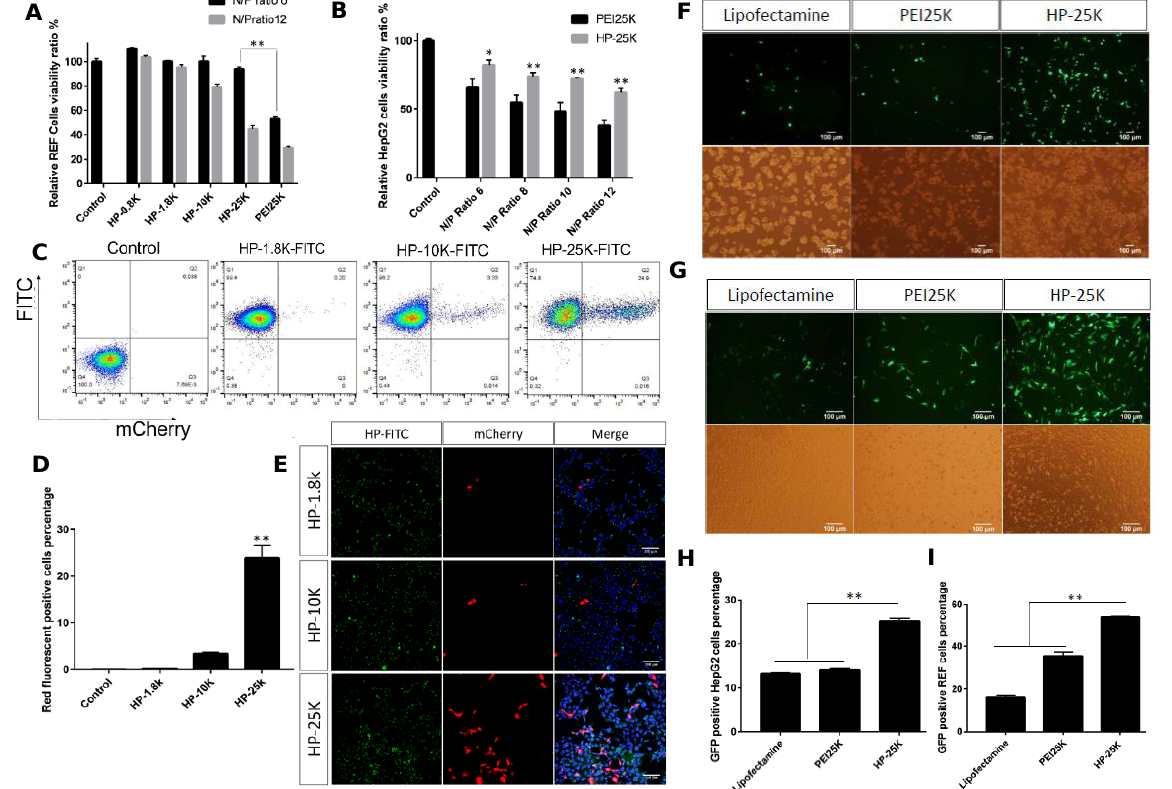
Figure 3. HPs safely and efficiently deliver fluorescence reporter gene pDNAs to various cell types. ( A ) REF cell survivability after transfection with different size HP-pDNA polyplexes. ( B ) HepG2 cell survivability after transfection with HP-25K or PEI25K -pDNA polyplexes at different N/P ratios. ( C ) Representative flow cytometry results of Ad293 cells transfected with HP-pmCherry-N1 polyplexes. ( D ) Quantitative summary of flow cytometry results. ( E ) Confocal microscopy images of Ad293 cells transfected with HP-pmCherry-N1 polyplexes. Green: FITC-labeled HP nanoparticles. Red: mCherry fluorescence. Blue: nuclei. Scale bar 100 µ m. ( F ) Microscopy images of HepG2 cells transfected with HP-eGFP polyplexes. Top: fluorescence microscopy images. Green: eGFP fluorescence. Bottom: light microscopy images. ( G ) Microscopy images of REF cells transfected with HP-eGFP polyplexes. Top: fluorescence microscopy images. Green: eGFP fluorescence. Bottom: light microscopy images. ( H ) Quantification of flow cytometry results of HepG2 cells transfected with HP-eGFP polyplexes. ( I ) Quantification of flow cytometry results of REF cells transfected with HP-eGFP polyplexes. * p < 0.05. ** p < 0.01.